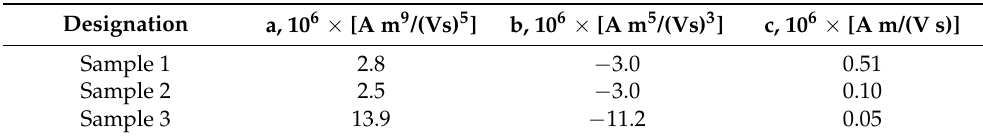
Table 5. The estimated values of a, b and c parameters used to model curves presented in Figures